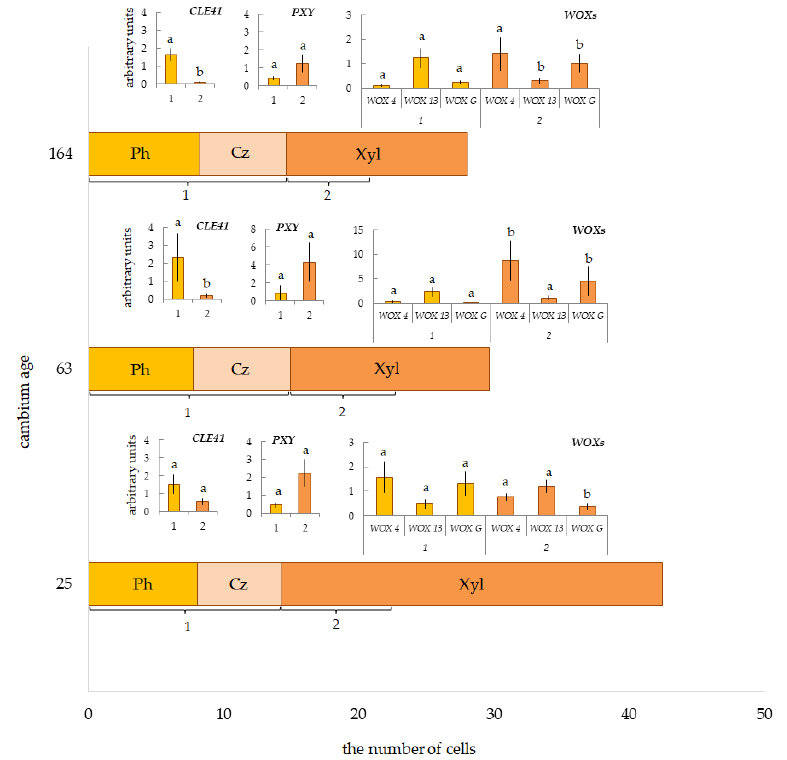
Figure 5. The number of cells in the radial row of conducting phloem (Ph), cambial zone (Cz), and current year xylem (Xyl) in pine plants of different ages. Relative expression of genes CLE41/PXY/WOXs in tissues, including the cambial zone, differentiating phloem and mature phloem (Fraction 1 (1)), and differentiating xylem (Fraction 2 (2)). Samples collected on 21–22 June 2021. Different letters show differences only between Fraction 1 and Fraction 2.